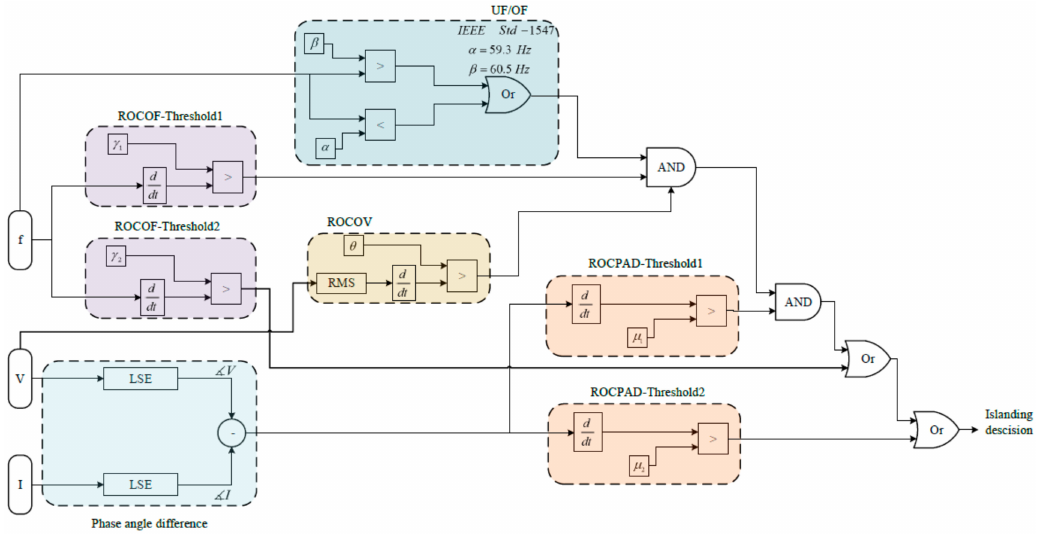
Figure 4. Proposed islanding detection